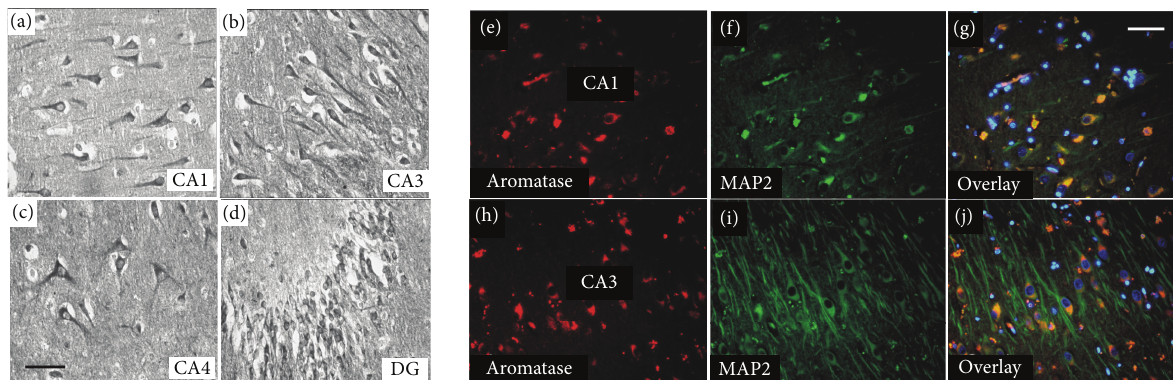
Figure 1: Neurons in all regions of the human hippocampus expressed aromatase (tissue obtained from an 89-year-old woman without any known neurological disease). (a–d) Immunohistochemical staining (DAB) for aromatase resulted in a strong signal in all hippocampal regions.(e–j)Coimmunostainingforaromatase(e,h)andtheneuronalmarkerMAP2(f,i)demonstratedthatprimarilyhippocampalneurons expressed aromatase. Aromatase-expressing neurons are orange in the overlay, and nuclei were stained blue with DAPI (g, j). Images were taken from the CA1 region (e–g) and the CA3 region (h–j). Scale bar: 50 𝜇 m; CA: cornu ammonis; DG: dentate gyrus.